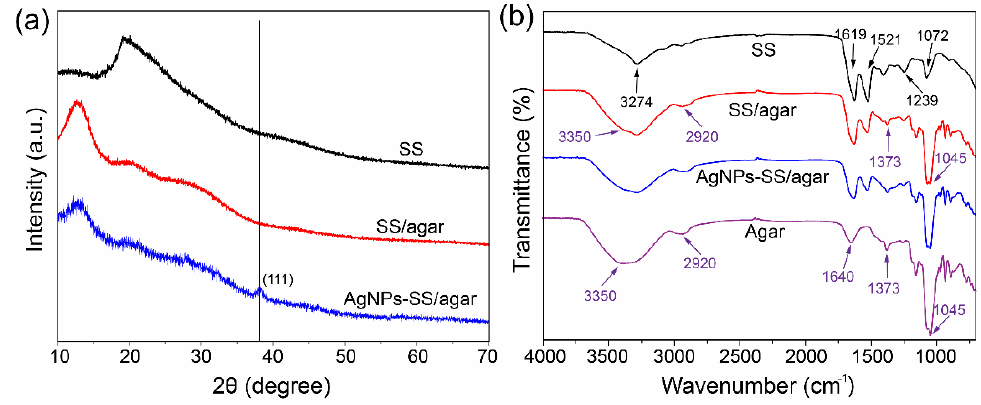
Figure 7. The characterization of different films. ( a ) XRD spectra; ( b ) FT-IR spectra.